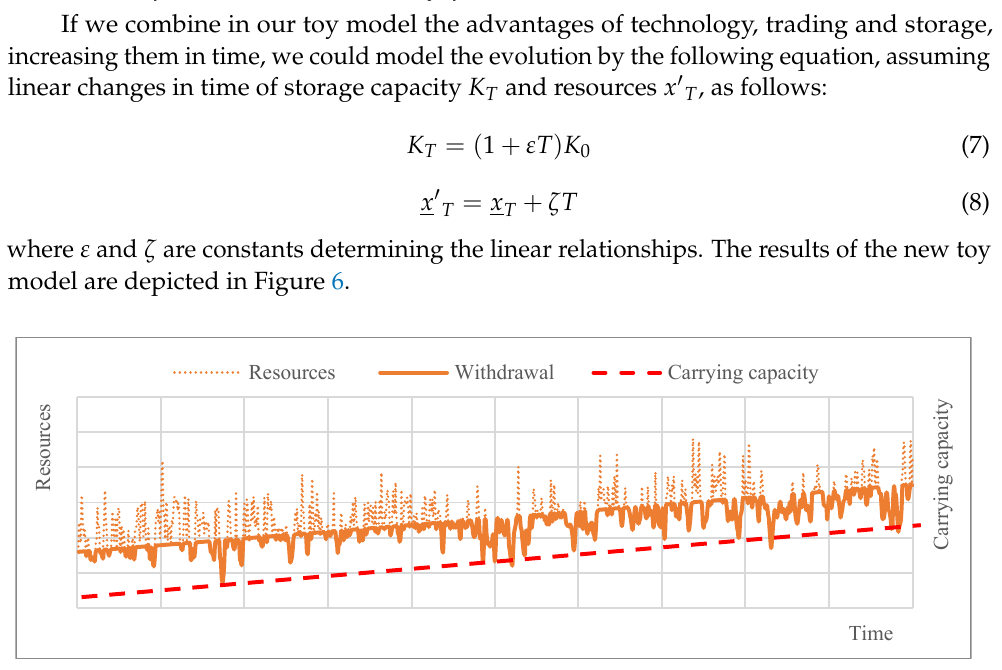
Figure 7. Toy model: The concept of environmental determinism with HK dynamics where storage and technology are increasing, but the available resources are not consumed sustainably.